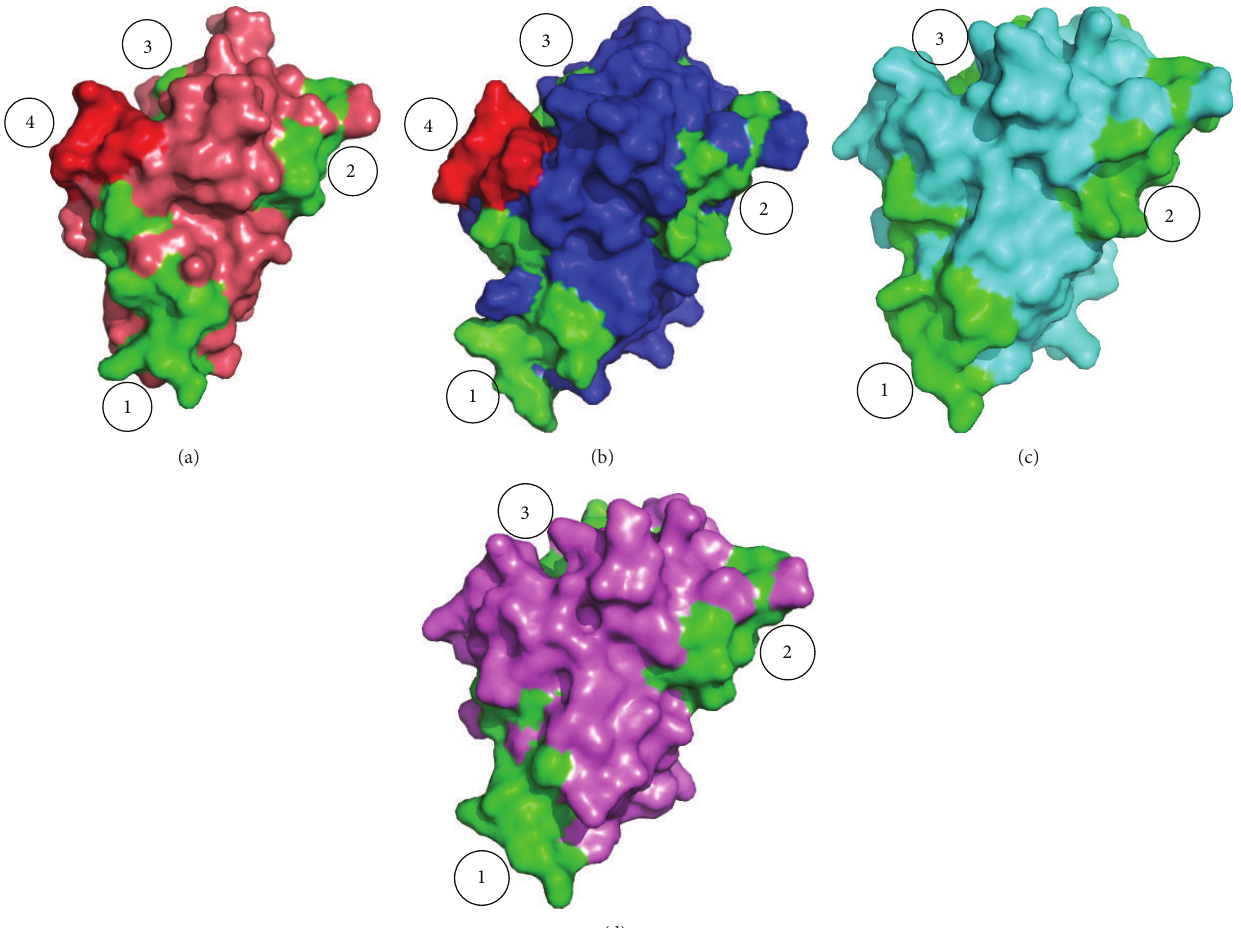
Figure 13: The three common surface epitopes (in green) recognized for IgE binding marked from 1 to 3 in (a) Bet v 1, (b) Pru av 1, (c) Api g 1, and (d) Dau c 1. The conformational epitope required for Fab binding (in red) in Bet v 1 (marked 4) is nearly conserved in Pru av 1 but absent in Api g 1 and Dau c 1 because of the absence of